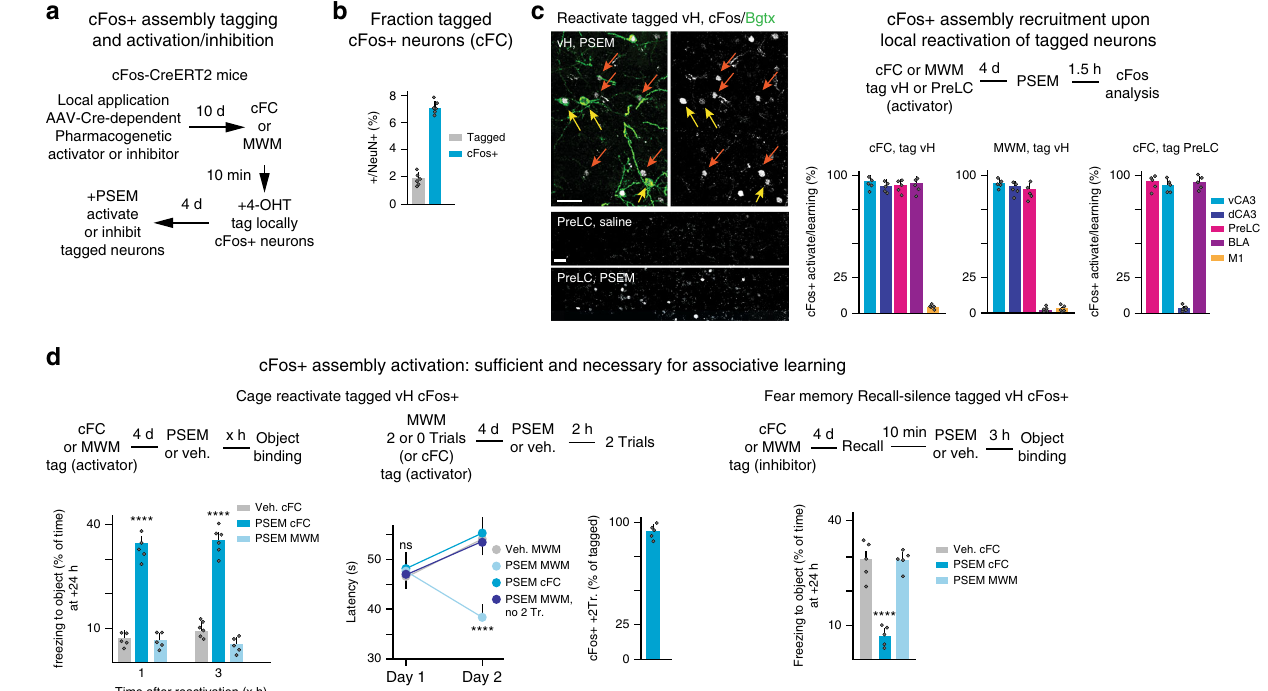
Fig. 5 Activity in local cFos + neuronal assemblies suf fi cient and necessary for time unit function. a Schematic of cFos + neuron tagging and reactivation protocols. 4-OHT: Tamoxifen derivative used in these experiments. b Fractions of tagged and total cFos + neurons upon cFC acquisition in vH. N = 6 mice each. c System-wide cFos + neuronal assembly recruitment upon local reactivation of tagged cFos + neurons. Left: representative images of vH tagged neuron re-activation experiment; yellow arrows: tagged (Bgtx + ) and cFos + neurons; orange arrows: cFos + neurons induced by activation of tagged neurons; Right: 0 h cFos + /NeuN + baseline values subtracted from learning values, and vehicle cFos + /NeuN + values subtracted from PSEM activation values; bars: 40 μ m. N = 5 mice for each group. d Role of cFos + assembly re-activation and inhibition for time unit function. Left: Reactivation of cFC (but not MWM) tagged vH cFos + neurons is suf fi cient for associative fear memory binding, Two-way ANOVA, Condition, P < 0.0001, n = 5, 6, 6, 6, 5, 5). MWM learning: re-activating, 4 days later (now de fi ned as Day1), vH cFos + neurons tagged after two trials is suf fi cient to replace the fi rst two trials in MWM learning [Two-way RM ANOVA, Interaction, P = 0.0017, Condition, P = 0.0030, n = 5; right: fraction of vH two-trials MWM tagged neurons that are cFos + after two more trials ( n = 5 mice). Right: fear memory recall 4 days after acquisition reopens a time unit for memory binding, which is suppressed by inhibition of tagged cFos + fear memory neurons (One-way ANOVA, P < 0.0001, n = 5 for each group). Error bars: SEM; P < 0.05 (*), 0.01 (**), 0.001 (***), 0.0001 (****). For a more detailed description of the statistical analysis please refer to Supplementary Table